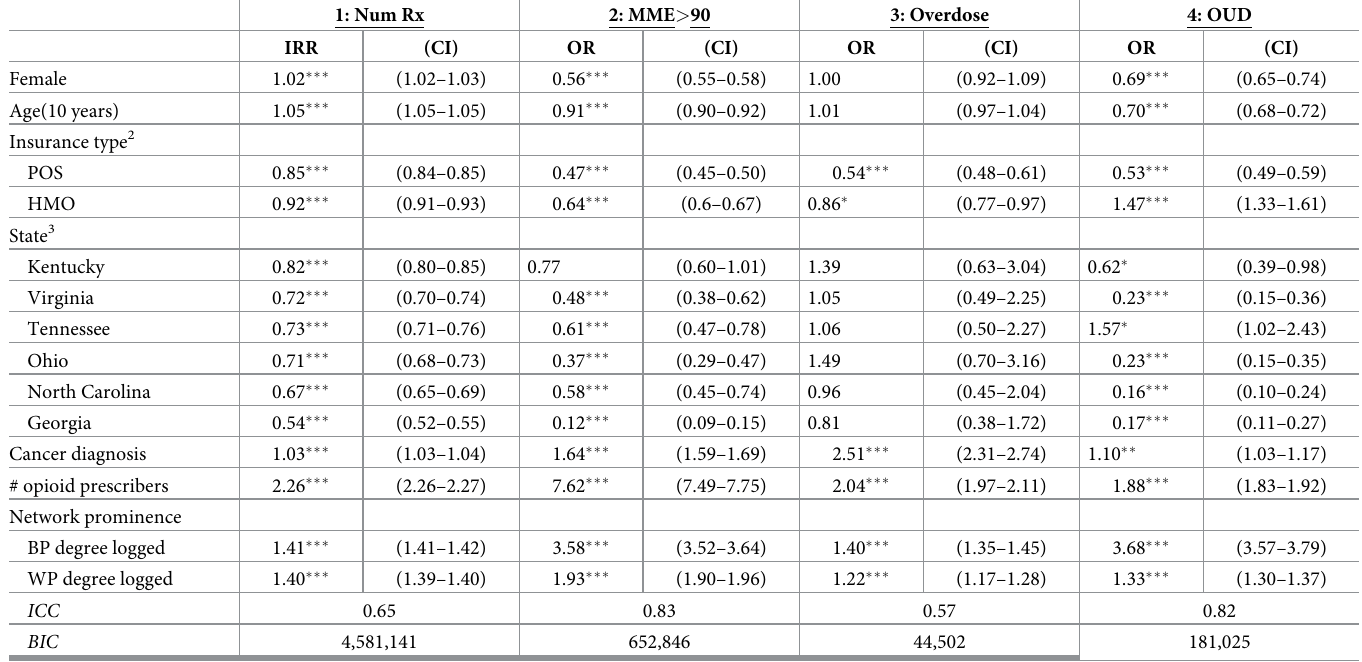
Table 6. Mixed effects regression 1 of opioid outcomes on between-person and within-person patient logged degree centrality and controls (n = 526,929; n obs =